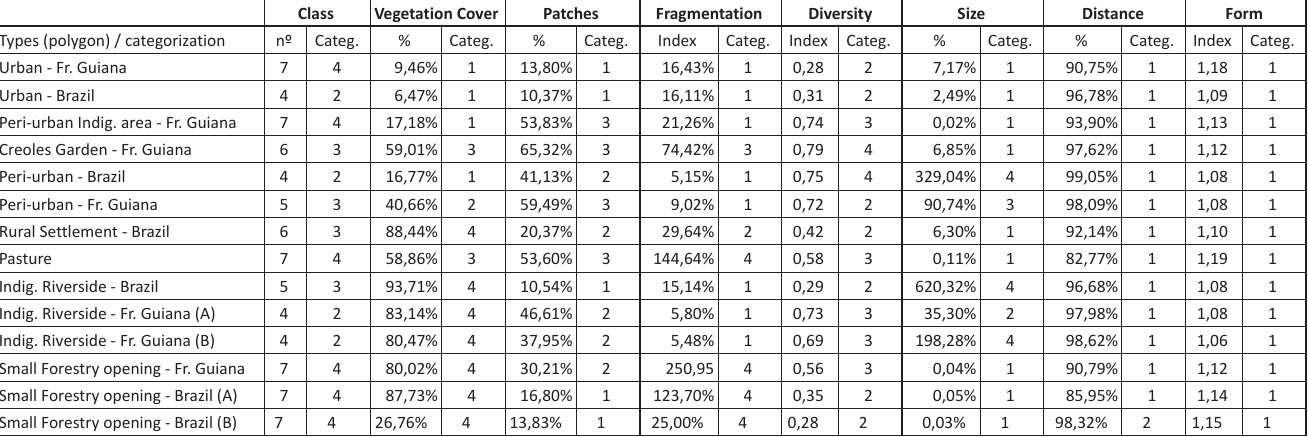
Table 4: Landscape metrics for each landscape